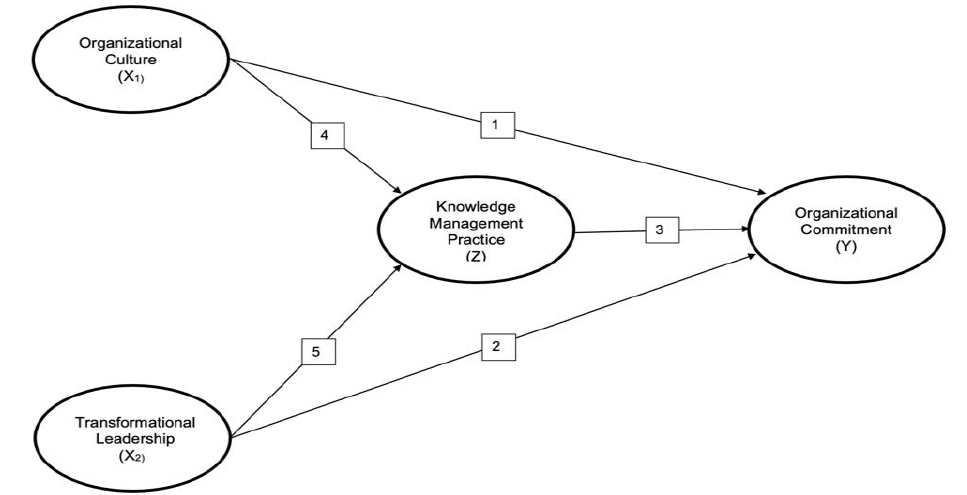
Figure 1: Research Framework and